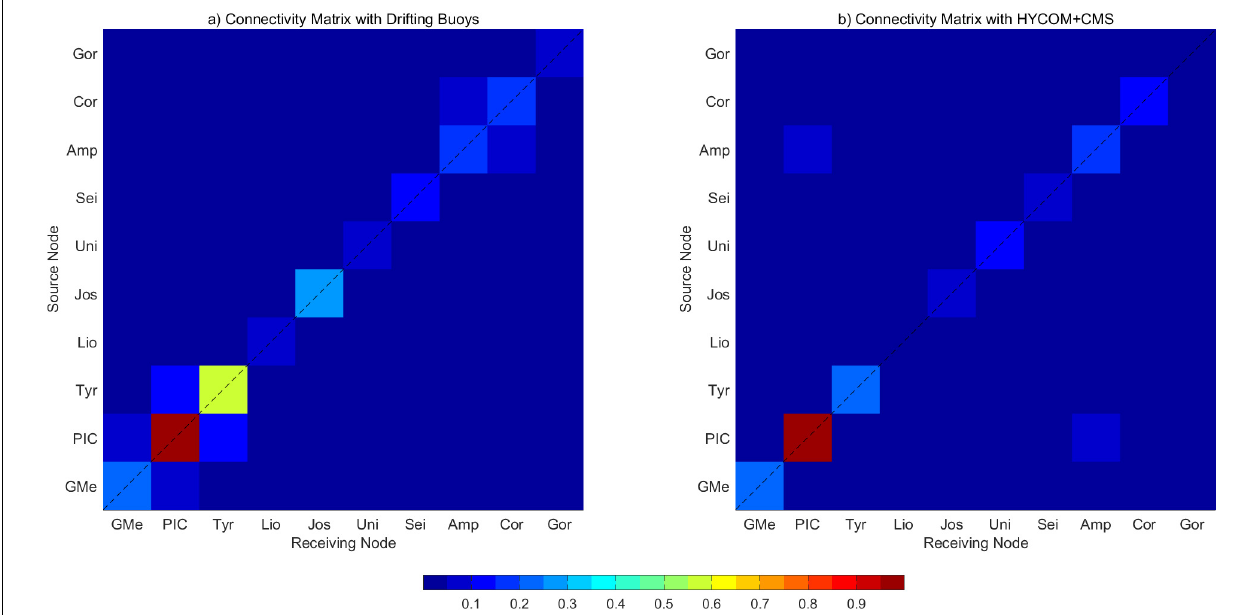
Frontiers in Marine Science |